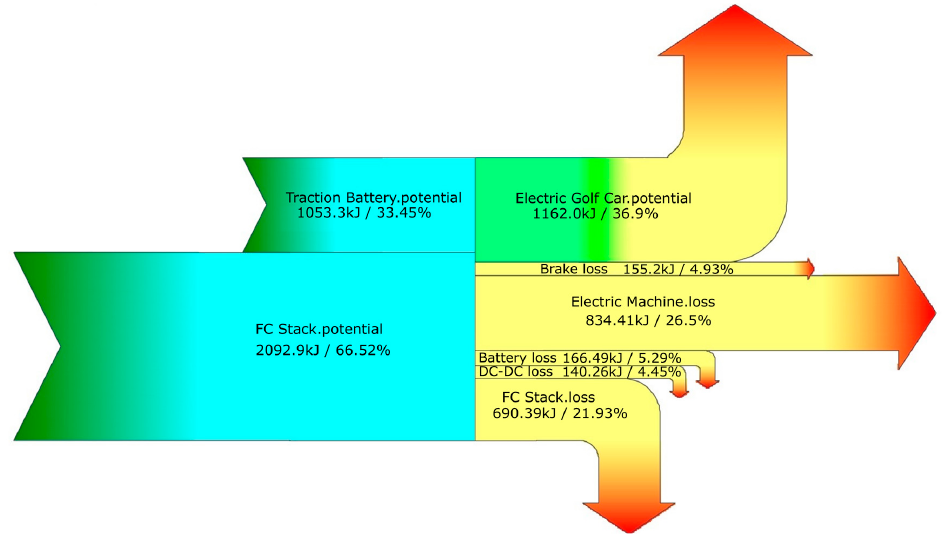
Figure 20. Sankey diagram of Fuel Cell Extend Range Electric Vehicle Model.